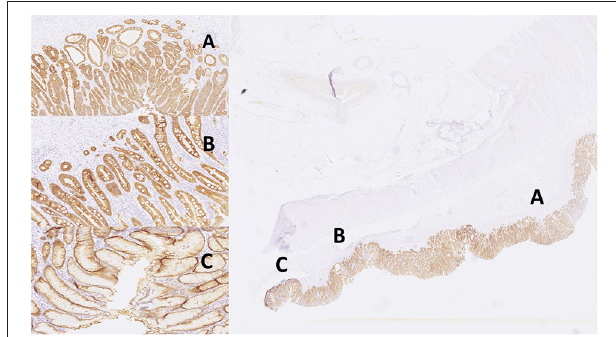
FIGURE 4 | Images of IHC expression by CK18 stain in different sites. Right: total; left top: gastritis; left middle: IM; left bottom: adenocarcinoma. (A) adenocarcinoma, (B) intestinal metaplasia, (C) gastritis.